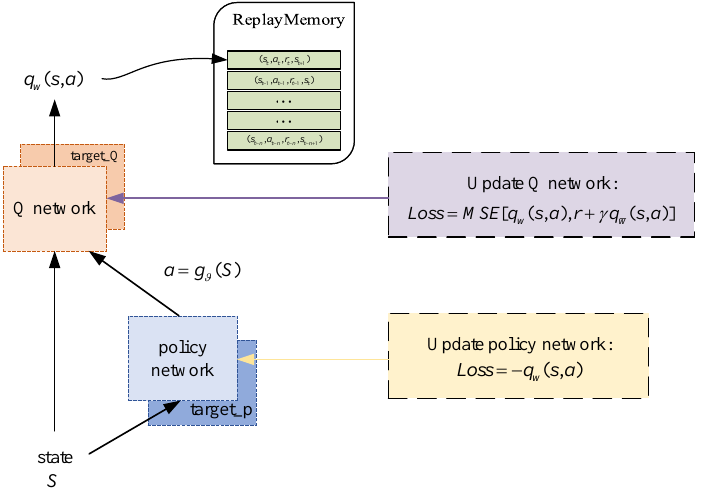
Figure 4. The structure of DDPG.